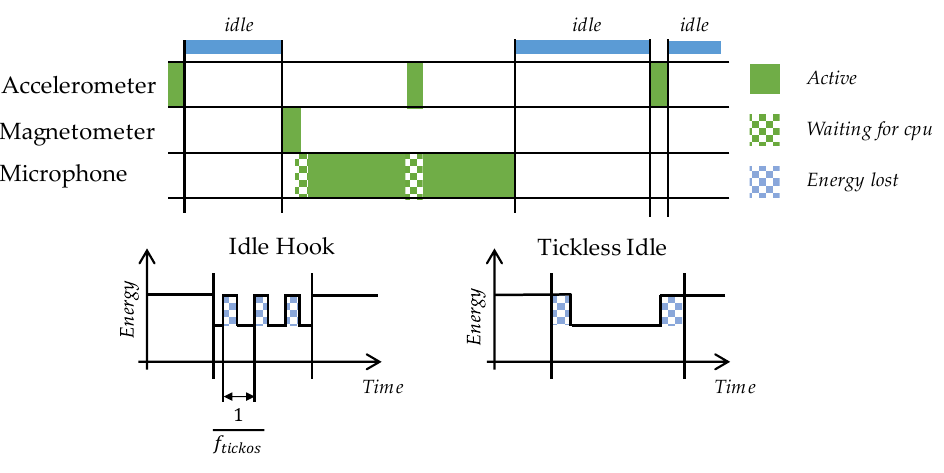
Figure 11. Low power strategies when using RTOS.